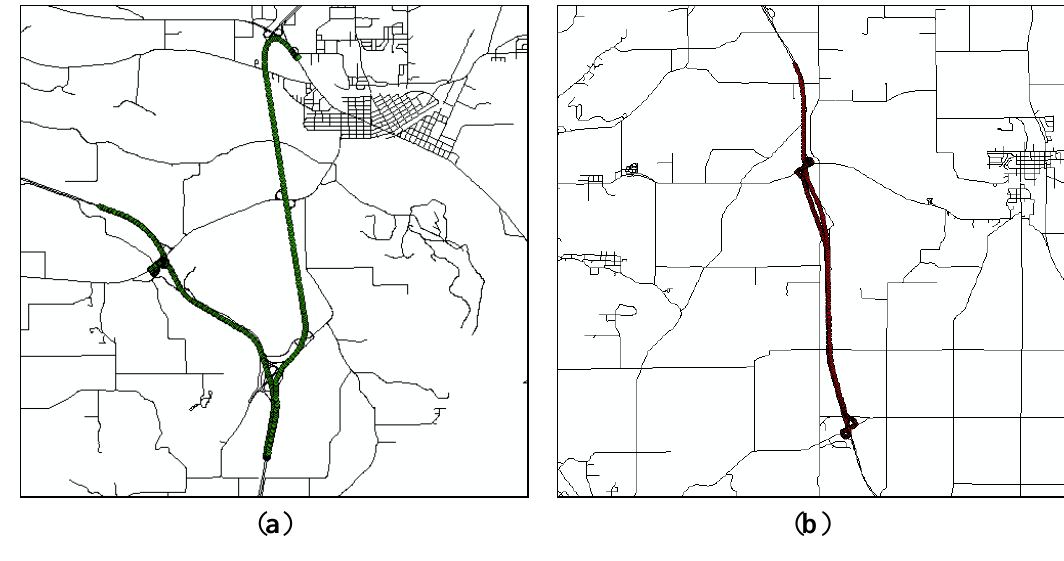
Figure 14. DGPS data points in Columbia County, WI, USA. ( a ) Operator ID: S0024; and ( b ) Operator ID: S0025.